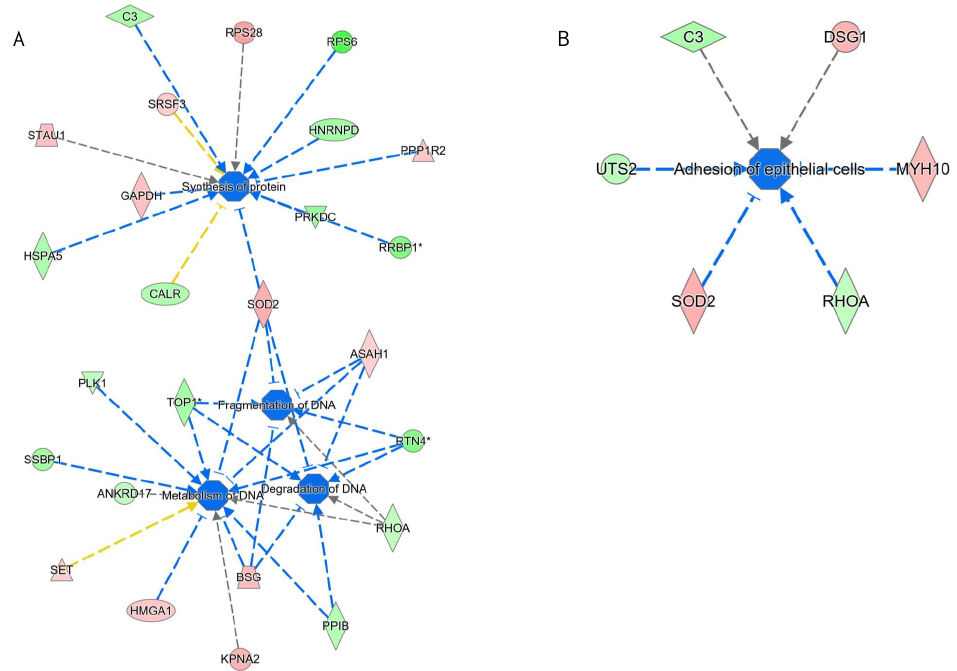
Figure 7. Negatively induced pathways (blue hubs) in NAFLD versus control cells: ( A ) Synthesis of proteins and DNA metabolism. ( B ) Adhesion of epithelial cell pathways. The intensity of the color is positively related to the up- (red) or downregulation (green) of genes; orange lines lead to activation, blue lines lead to deactivation, yellow lines represent findings inconsistent with the state of the downstream molecule, and gray lines represent effects that were not predicted. The * indicates the presence of protein isoforms.